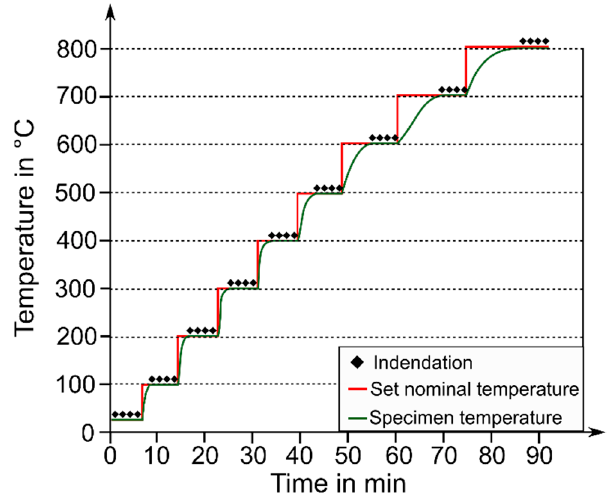
Figure 1. Schematic time-temperature profile of the in situ hot hardness tests.